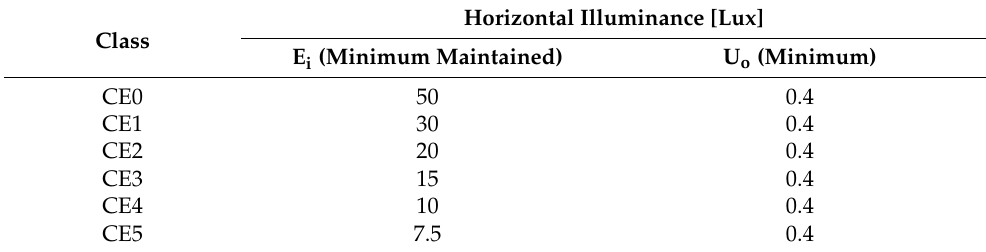
Table 1. Performance requirements for CE Series of Lighting Classes